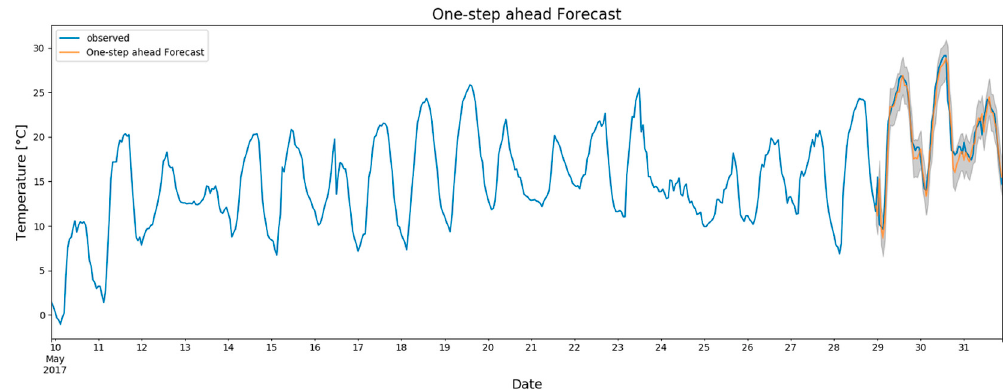
Figure 13. Training data and forecasting results in the static mode for the raw temperature data time series obtained from the IBIS measurements with a SARIMAX (1, 0, 2) × (0, 1, 2) 24 model.